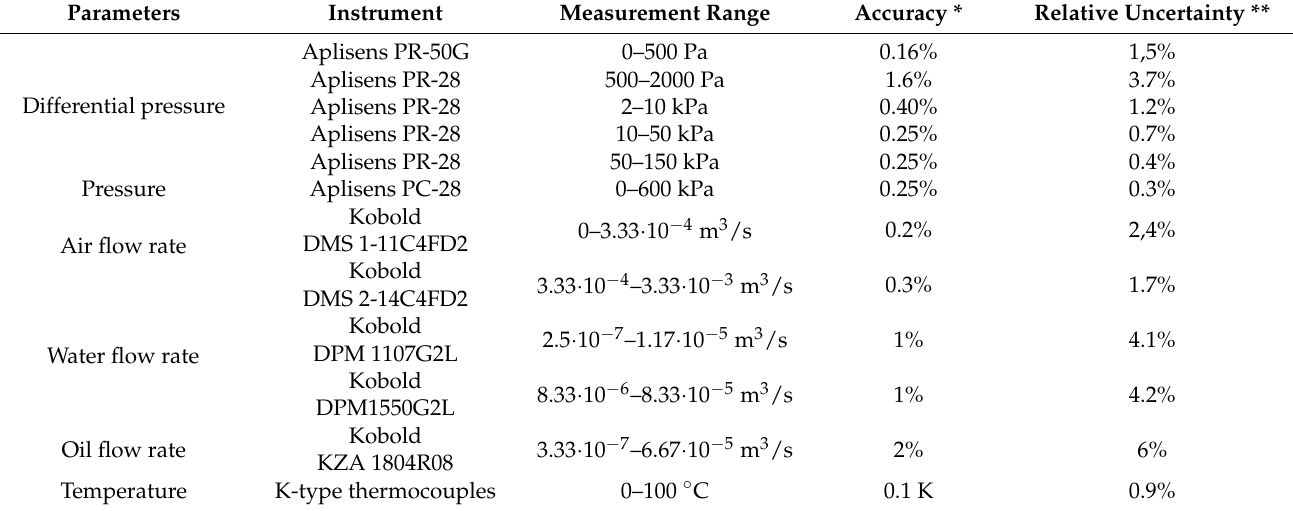
Table A1. Uncertainties of the measured